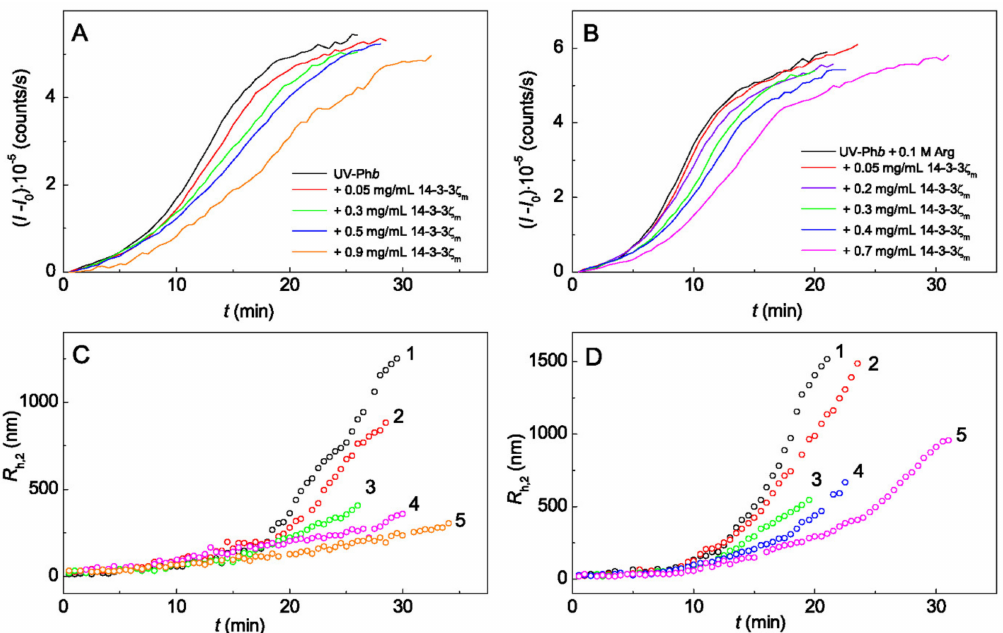
Figure 3. E ff ect of 14-3-3 ζ m on the kinetics of aggregation of UV-Ph b (0.25 mg / mL) in the absence ( A , C ) and in the presence of 0.1 M Arg ( B , D ) at 37 ◦ C. ( A , B ) The dependences of the light scattering intensity ( I − I 0 ) on time. The concentrations of 14-3-3 ζ m are shown in panels ( A , B ). ( C , D ) The dependences of the hydrodynamic radius R h,2 of protein aggregates on time obtained at the following concentrations of 14-3-3 ζ m : in panel ( C ) (1) 0, (2) 0.05, (3) 0.3, (4) 0.7 and (5) 0.9 mg / mL; in panel ( D ) (1) 0, (2) 0.05, (3) 0.3, (4) 0.4, and (5) 0.7 mg /